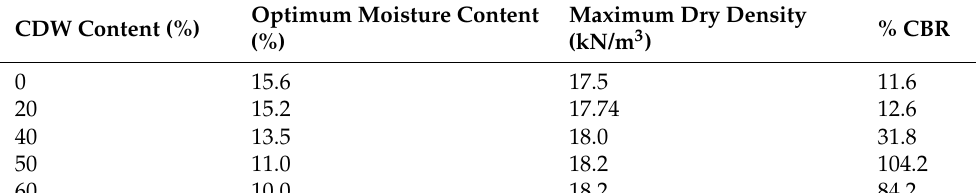
Table 6. CBR results with modified Proctor energy (56 blows) in soil mixes with ceramic CDW.